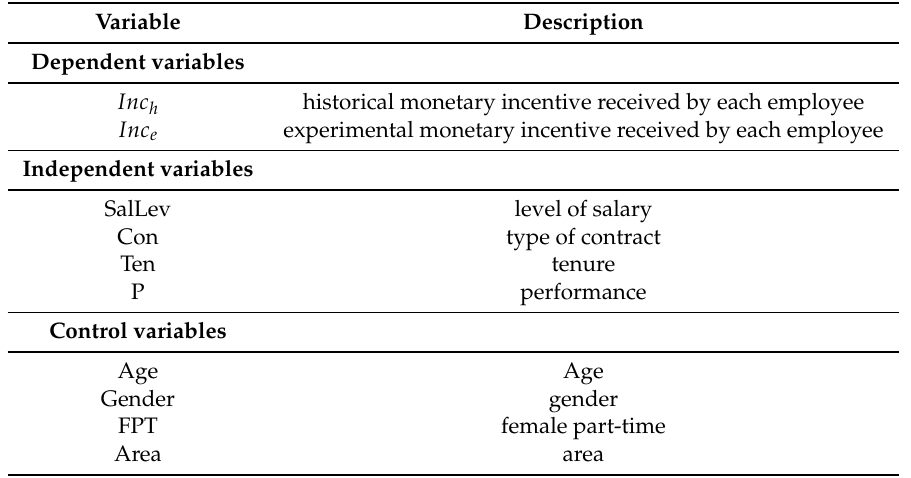
Table 5. Variables of the linear regression models described in Equations (4) and (5).